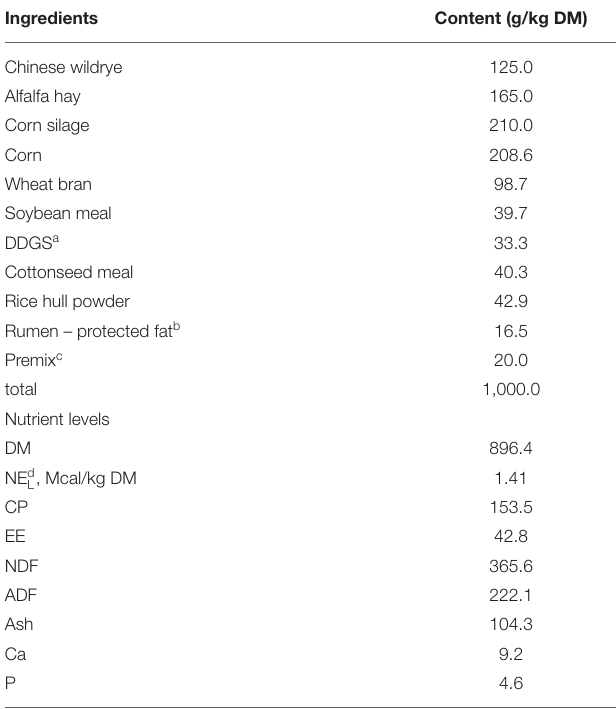
TABLE 1 | Composition and nutrient levels (g/kg dry matter) of experimental diets.